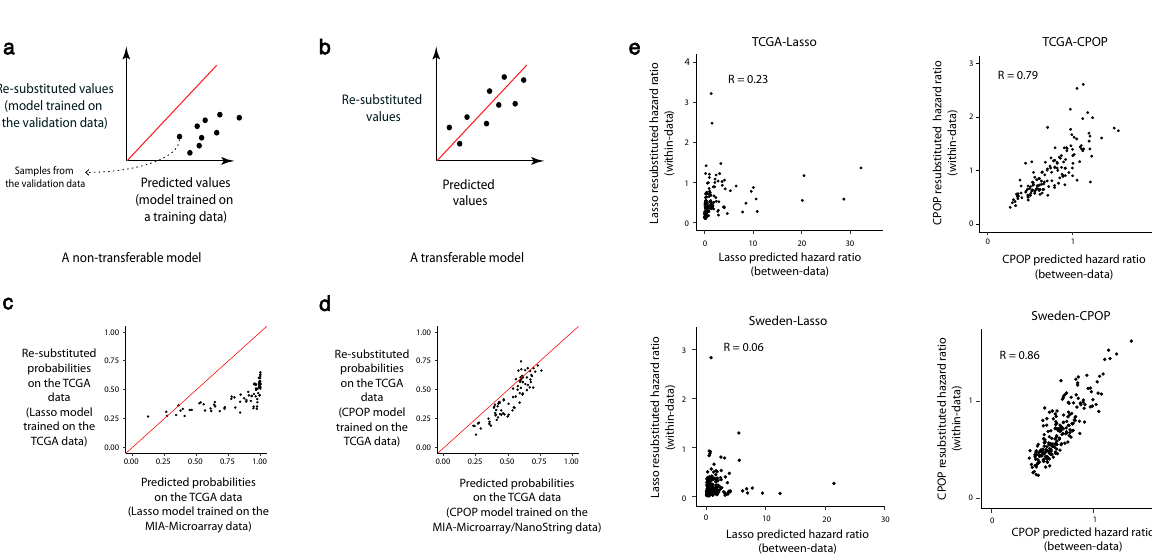
Fig. 2 Schematic drawings and fi gures for the comparison between prediction values and re-substituted values. a , b Schematic drawing of a non-transferable and a transferable model, respectively. By fi xing the samples in a validation data to be the same, we can compare a model ’ s prediction values (a model trained using training samples independent of the validation data) and the re-substituted predicted value (a model with the same con fi gurations but trained using the validation data itself). A transferable model should produce predicted values on identical scales as the re-substituted predicted values and so each point on the scatterplot, representing a sample in the validation data, should be randomly scattered around the identity line (y = x). A non-transferable model typically exhibits biases and clustering away from the identity line. c A real-data illustration of a non-transferable Lasso model, trained on the MIA-Microarray data and validated on the TCGA melanoma data. d A real-data illustration of a transferable CPOP model, trained on the MIA-Microarray and MIA-NanoString data and validated on the TCGA melanoma data. e Scatter plot illustrating the concordance between between-data predicted hazard ratios and within-data (re- substituted) hazard ratios. We trained a CPOP penalised Cox model with recurrence-free survival times as the response by combining the MIA- Microarray and MIA-NanoString data. Each of the four panels illustrates a combination of the Lasso and the CPOP model predictions on the TCGA and the Sweden data. R denotes the Pearson ’ s correlation coef fi